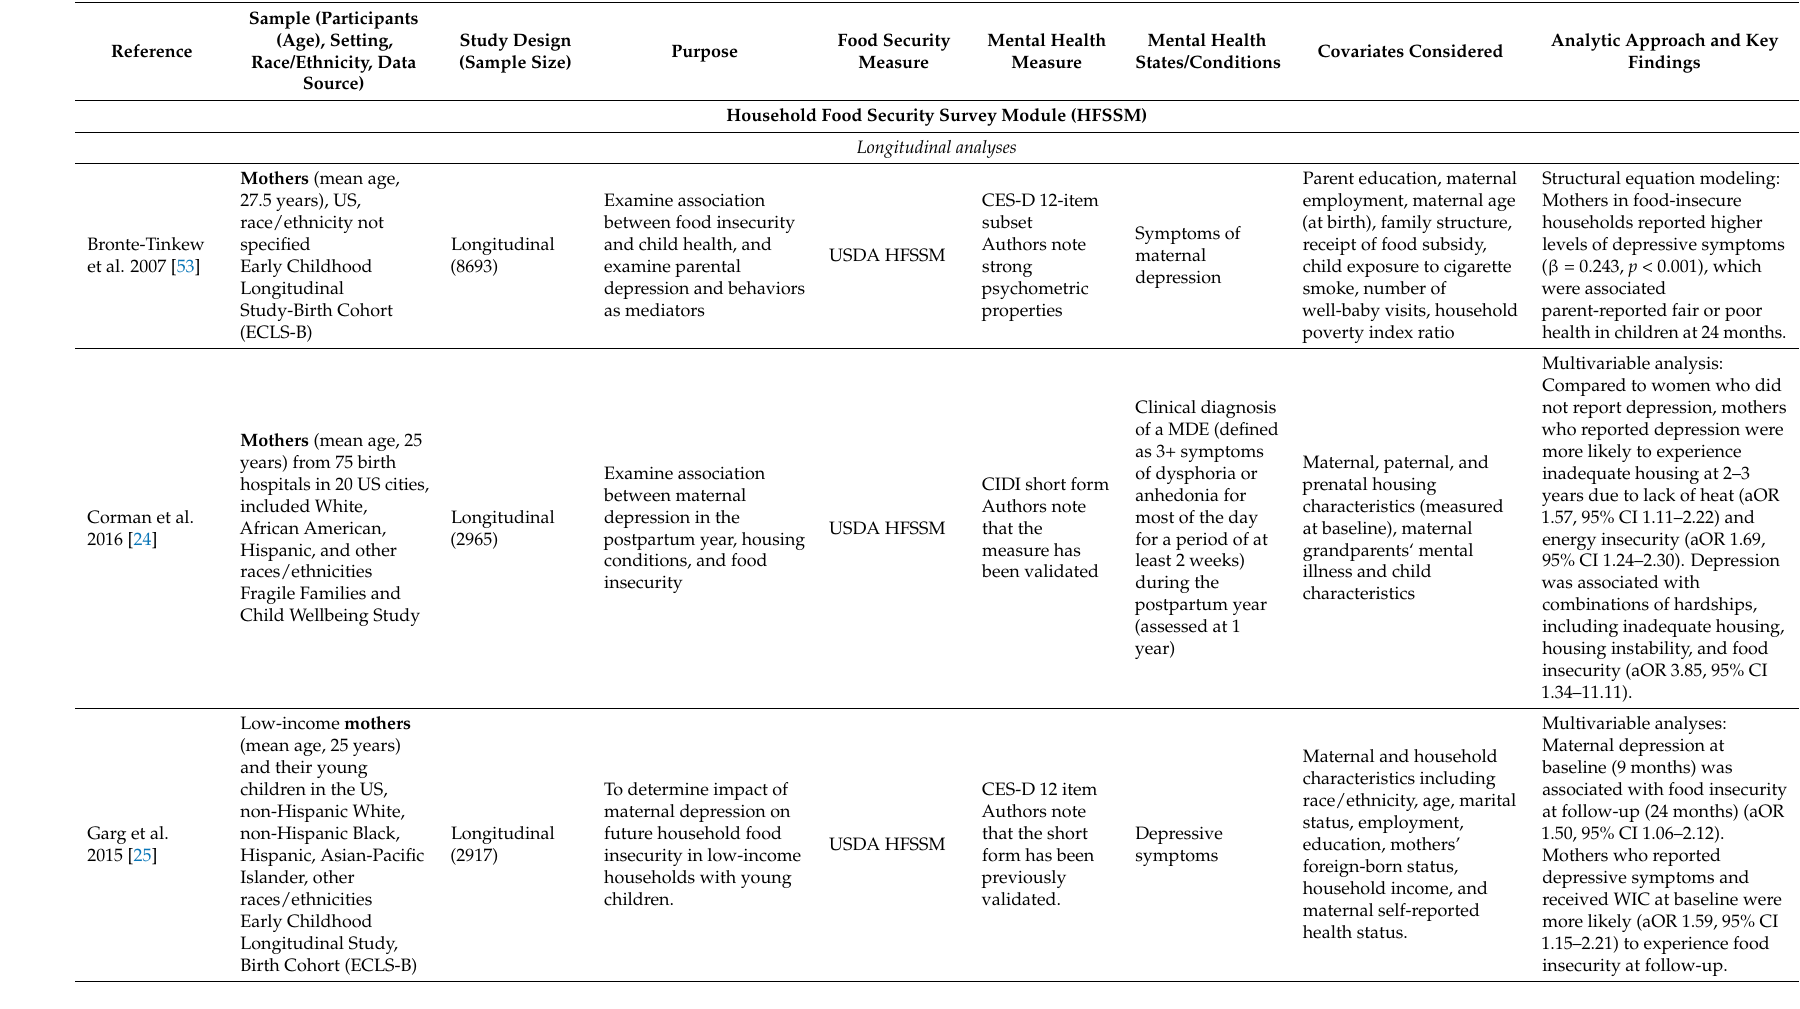
Table A1. Key characteristics of articles ( n = 39 from 31 studies/surveys) included in scoping review of food insecurity and mental health among women in high-income countries, by measure of food